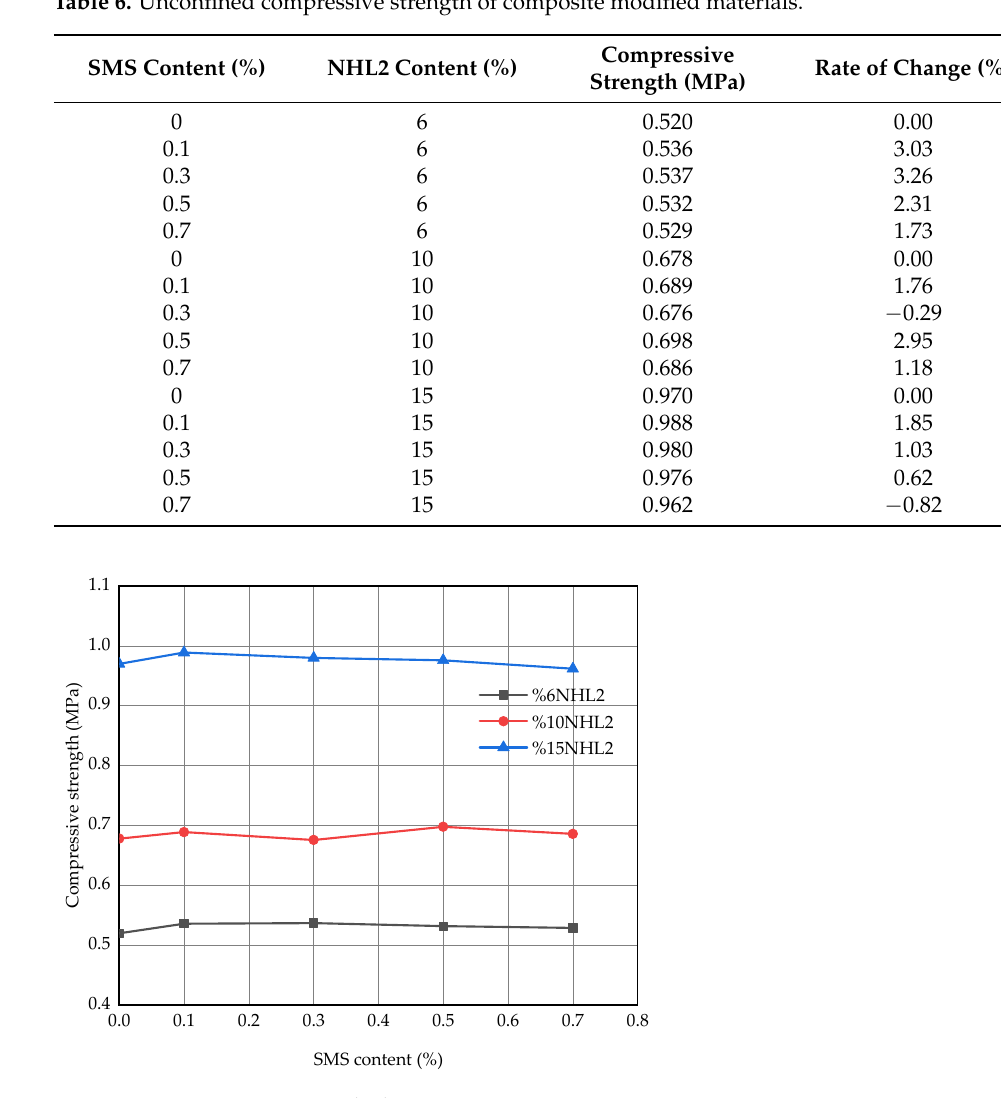
Table 6. Unconfined compressive strength of composite modified materials.